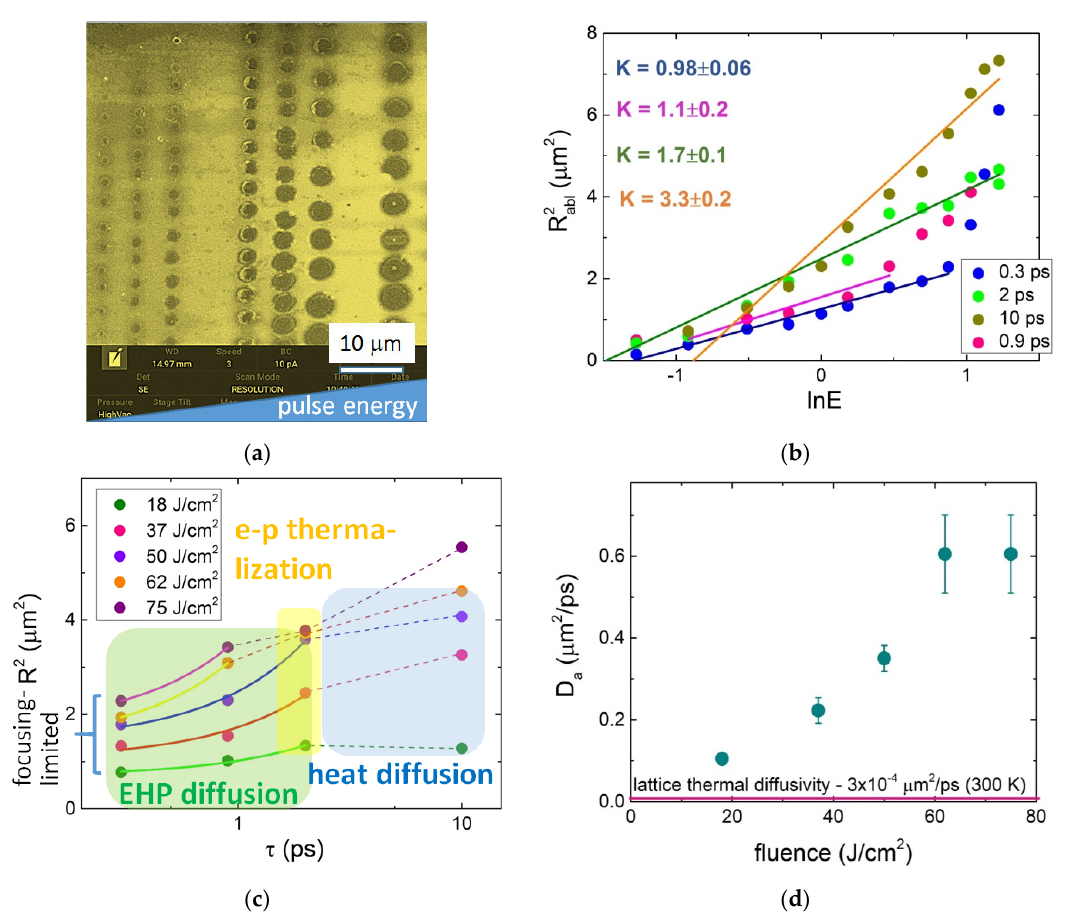
Figure 7. ( a ) Typical single ‐ shot craters on natural diamond surface produced by 1030 nm laser pulses of variable pulsewidths τ = 0.3–10 ps and pulse energies, focused at NA = 0.65; ( b ) dependence R abl2 lnE [ μ J], showing the characteristic squared energy deposition radii as linear slopes K; ( c ) R abl2 dependences (color circles and dashed curves) on lg τ with linear fitting slopes for R abl2 τ (solid lines), which start at the focusing ‐ limited squared radii at ambipolar diffusion timescale of 0–2 ps, ending up with electron–phonon (e–p) thermalization and heat diffusion; ( d ) derived ambipolar diffusion coefficient D a as a function of laser fluence and the horizontal line showing the corresponding maximal room temperature lattice thermal diffusivity χ ≈ 3 × 10 –4 μ m 2 /ps (3 cm 2 /s [104]). Hence, very similarly to Si, one can consider both considerable Auger recombination and carrier ‐ lattice thermalization terminated at 2 ps. The corresponding diffusive transport coefficient was evaluated as follows: